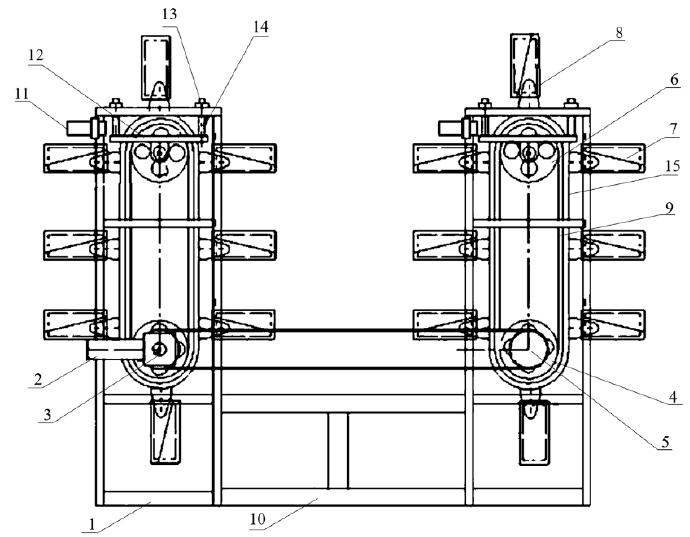
Figure 2. Automatic device for the operation to turn over the Daqu (1: rack of device for turning over